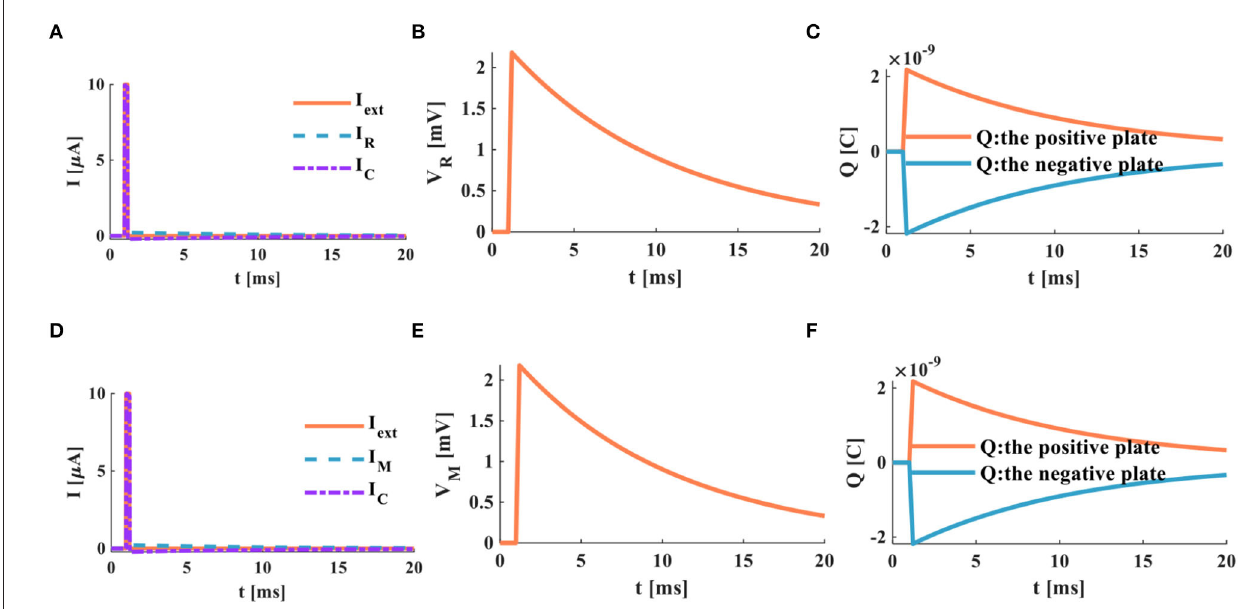
FIGURE 13 | A single pulse acts on the RC and MC neuron circuits, (A) the current flows through the resistor R and the capacitor C, (B) the membrane potential of the RC circuit, (C) the charges on the positive and negative plates in the RC circuit, (D) the current flows through the memristor M and the capacitor C, (E) the membrane potential of the MC circuit, (F) the charges on the positive and negative plates in the MC circuit.